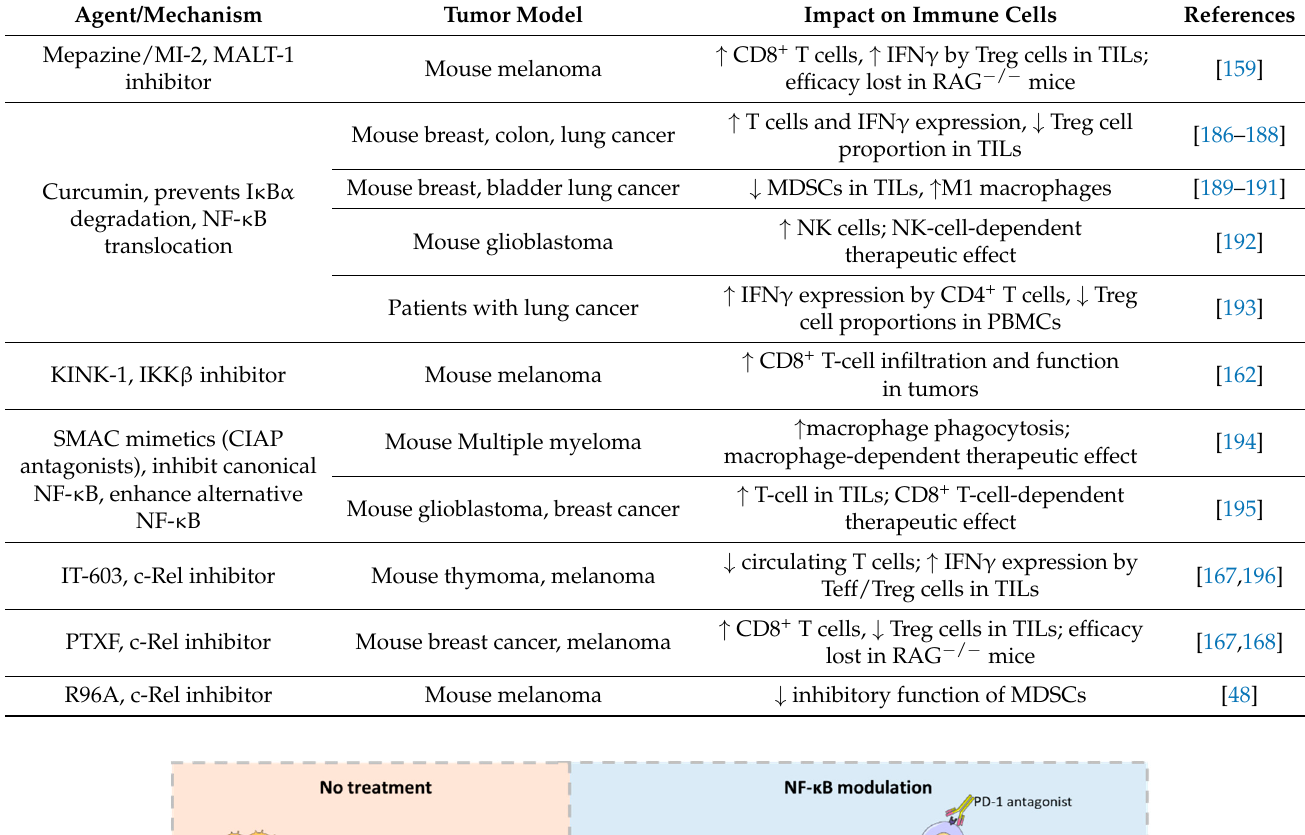
Table 1. Effect of NF- κ B inhibitors on cancer immunity. This table highlights some of the studies aiming at evaluating monotherapy-induced immune responses in the context of cancer in vivo. In vitro assays and other diseases are not discussed.